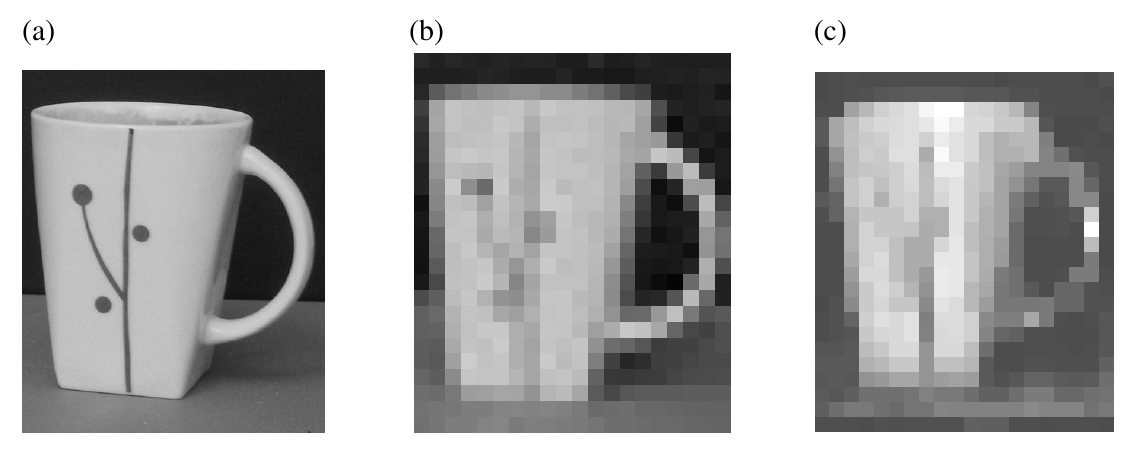
Figure 11. Example images: (a) taken with a commercial CCD camera; (b) same as previous but with the resolution changed to match that of the prototype; and (c) taken with the VI-CMOS